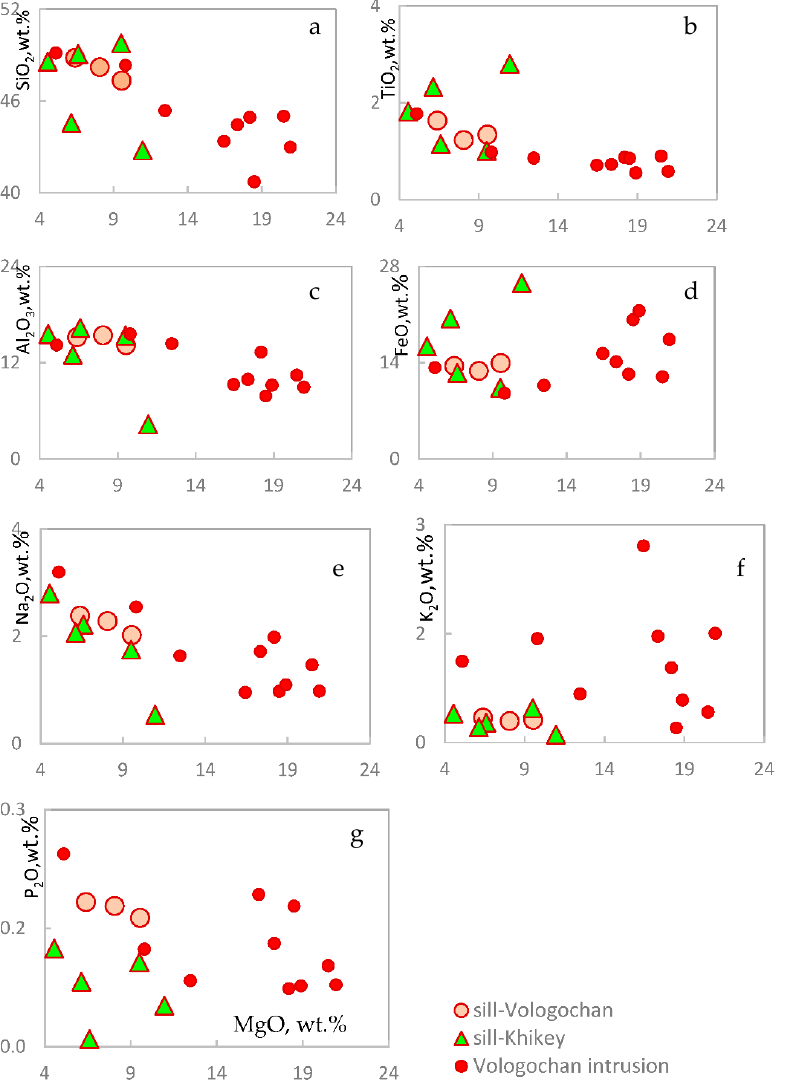
Figure 16. Diagrams MgO vs. SiO 2 ( a ), TiO 2 ( b ), Al 2 O 3 ( c ), FeO ( d ), Na 2 O ( e ), K 2 O ( f ), P 2 O 5 ( g ), % for intrusive rocks.